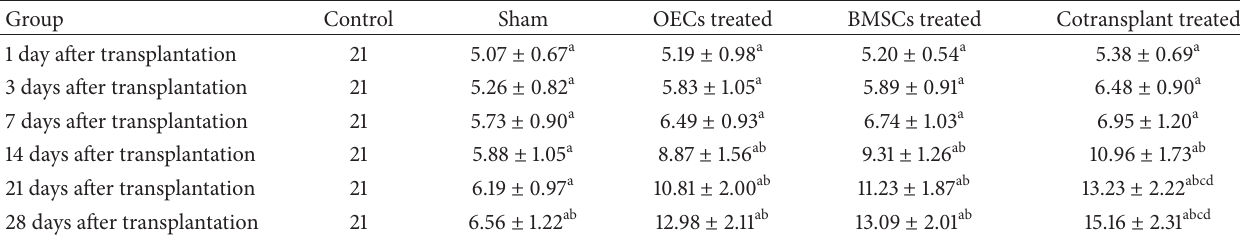
Table 3: BBB scores of rats with SCI after OECs and MSCs transplantation treatments ( 𝑥 ±